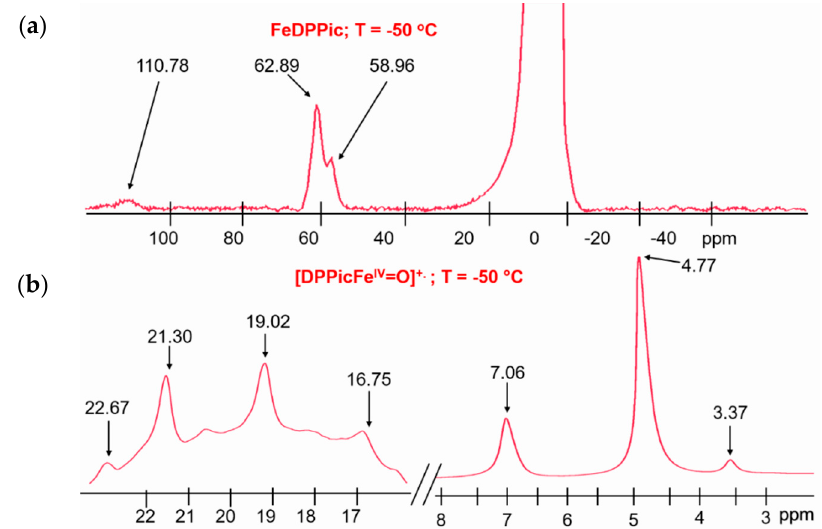
Figure 6. ( a ) 1 H-NMR of [FeDPPic] with chemical shifts of meso -protons at 110.78 ppm and methyl- protons at 63.89 and 58.96 ppm; ( b ) 1 H-NMR of [DPPicFe IV =O] +· with the highest chemical shifts at 22.67 ppm and with no possibilities of assignation.